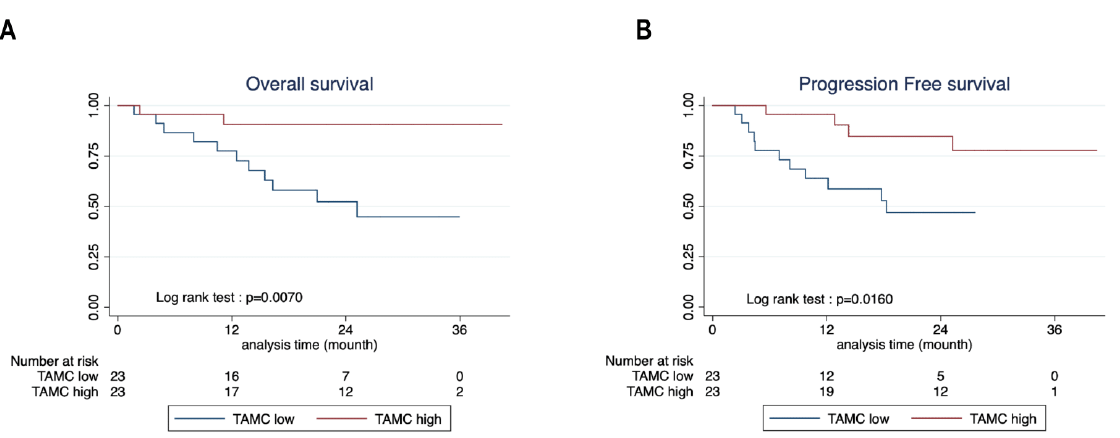
Figure 6. High TAMC frequency is associated with a good prognosis in the surgical cohort. ( A , B ) Kaplan–Meier curves showing the ( A ) overall survival (OS) and ( B ) progression-free survival (PFS) of 23 TAMC high (red) and 23 TAMC low (blue) patients with surgical stage NSCLC. TAMC high and TAMC low were separated according to the median of TAMC frequency in the immune infiltrate as measured by flow cytometry (Figure 1E).